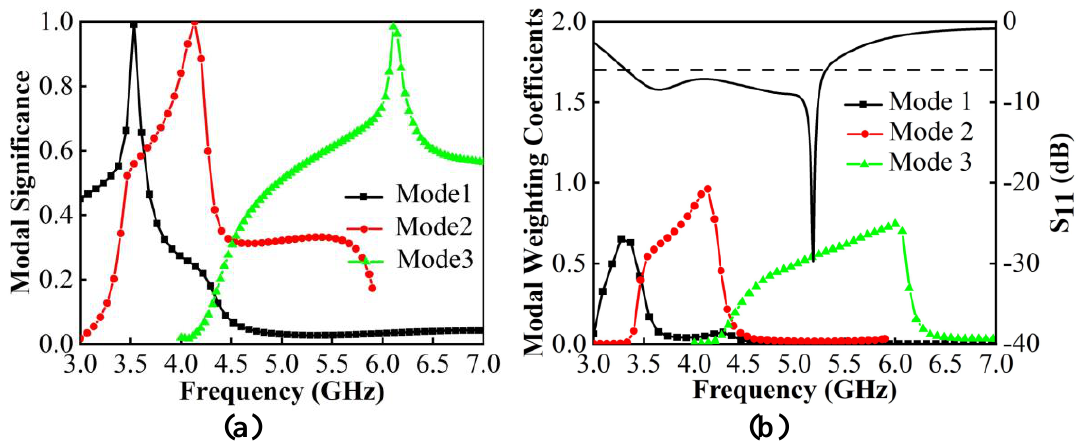
Figure 6. CMA of Case 3. ( a ) MS. ( b ) MWC.